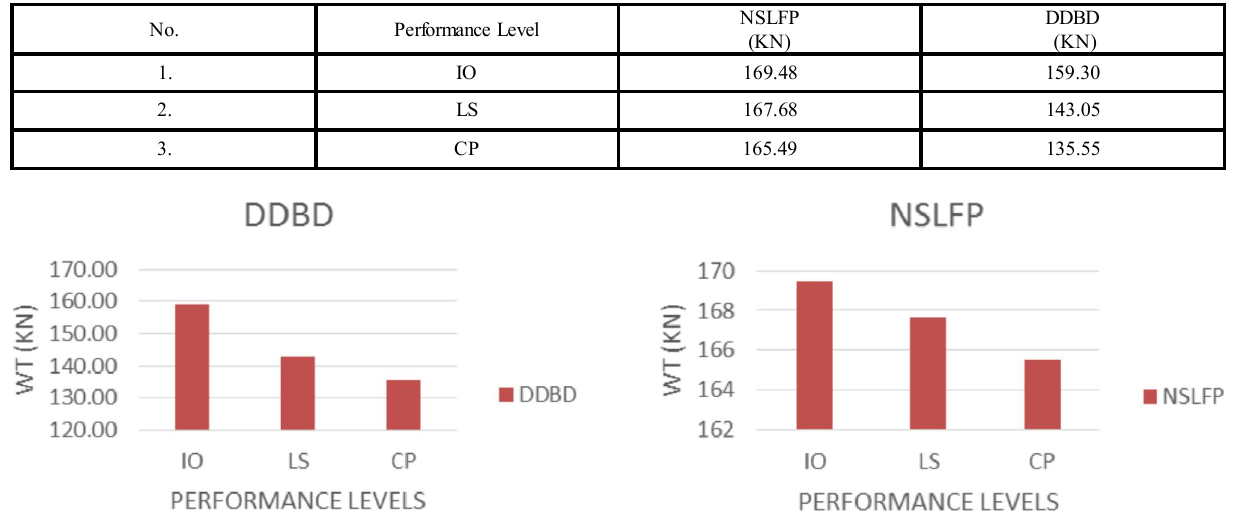
TABLE 3. STRUCTURAL WEIGHTS FOR OPTIMIZED SOLUTIONS